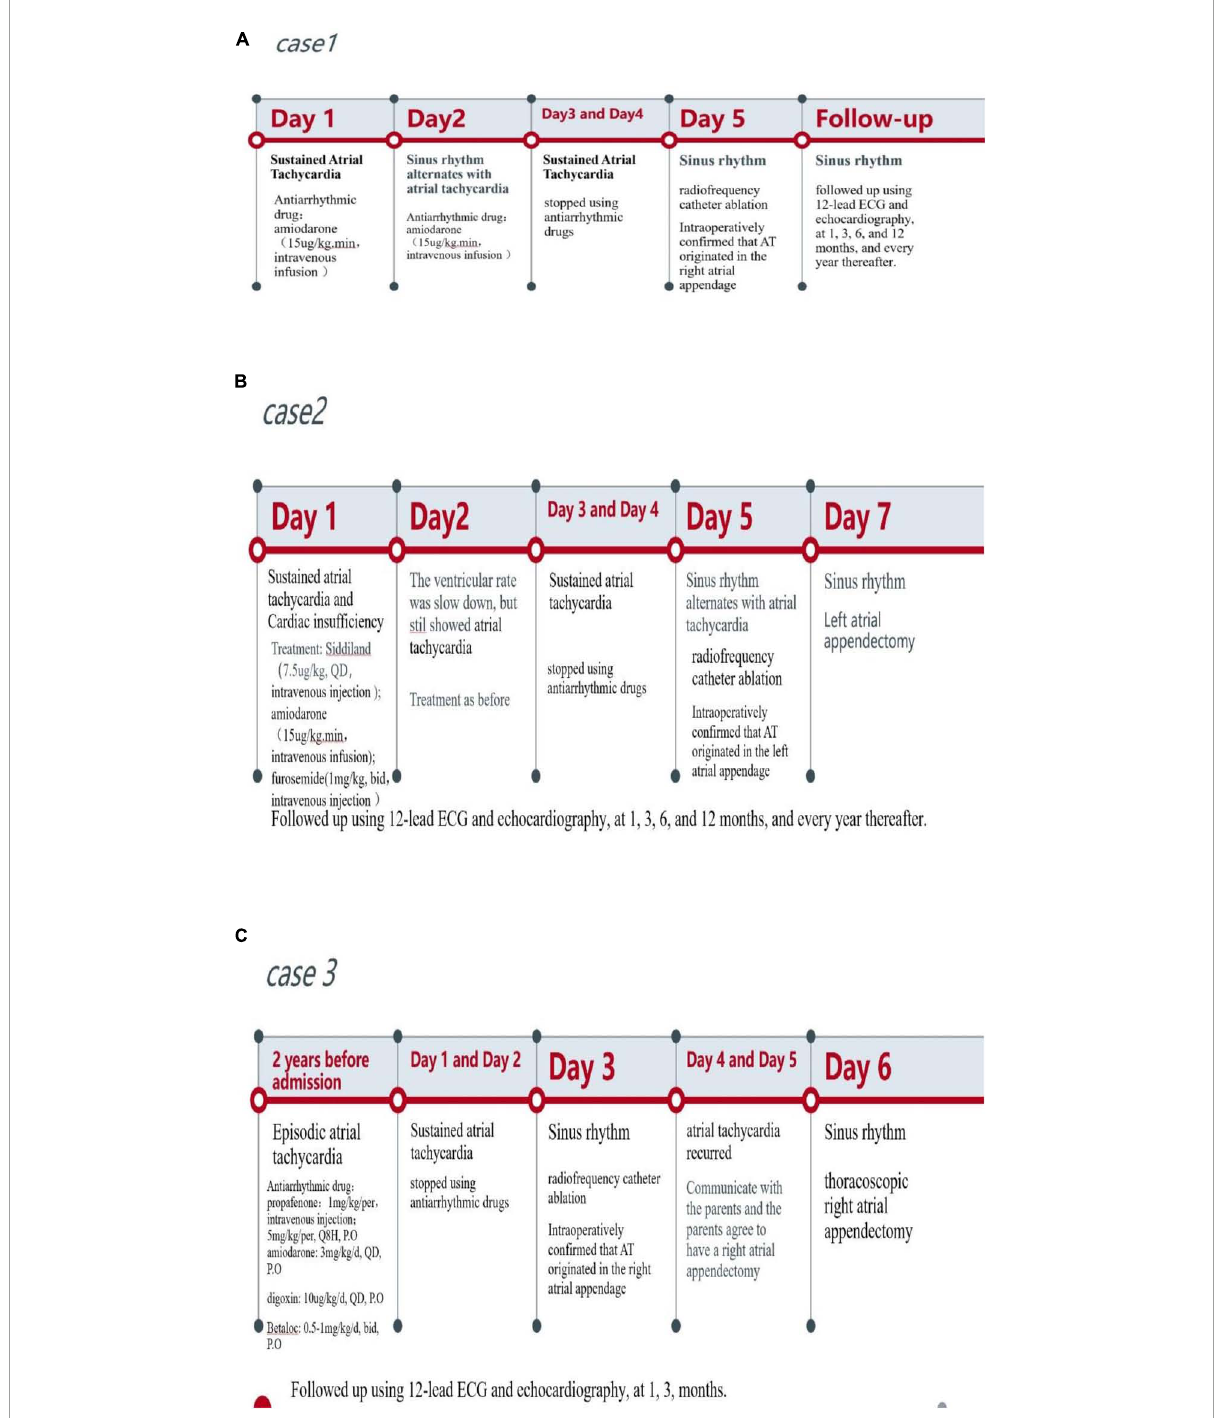
FIGURE5 The timeline of the three cases. (A) The timeline of case 1. (B) The timeline of case 2. (C) the timeline of case 3.